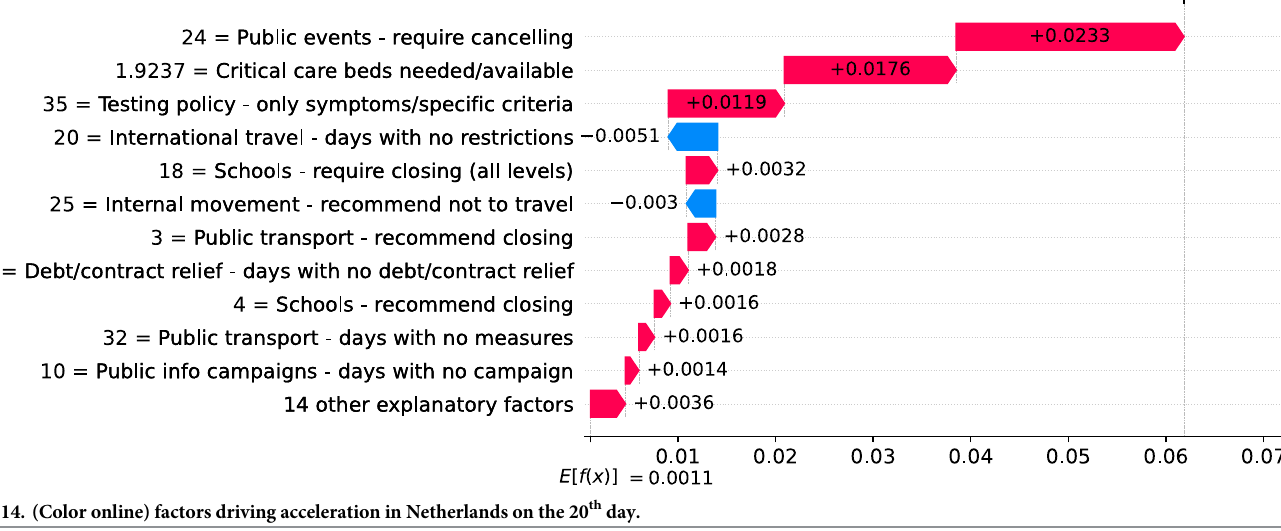
PLOS ONE | https://doi.org/10.1371/journal.pone.0264893 April 8,